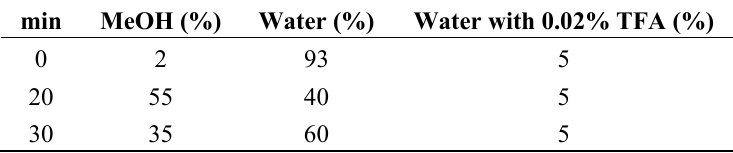
Table 1. Gradient profile. The column was washed 80% methanol ( v / v ) for ten minutes